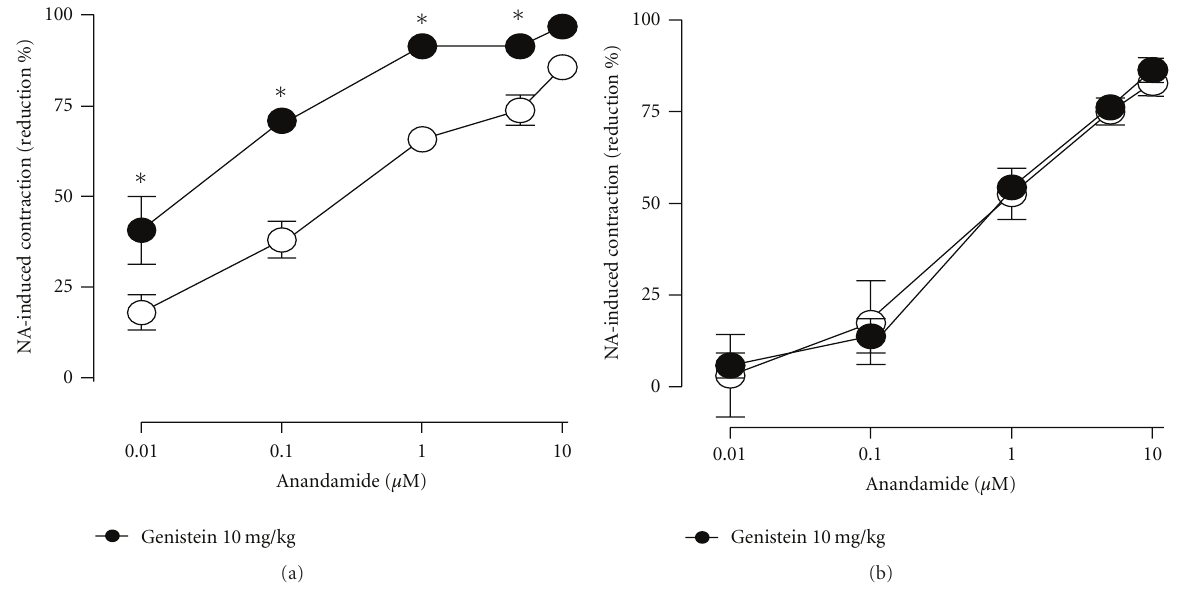
Figure 1: E ff ects of 3-day oral administration of 10 mg/kg genistein (filled circles) on anandamide-induced reductions of contractile responses to NA in mesenteric vascular beds isolated from female (a) as well as male (b) rats. Vehicles are depicted in open circles. ∗ P < 0 . 05 when treatment with genistein was compared to the corresponding